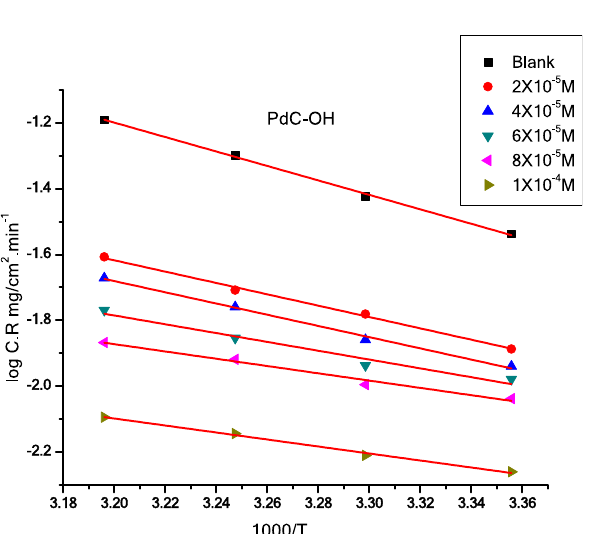
Figure 6. Arrhenius plot (log C.R vs 1000/T) for carbon steel in 1 M HCl with and without various concentrations of PdC-OH